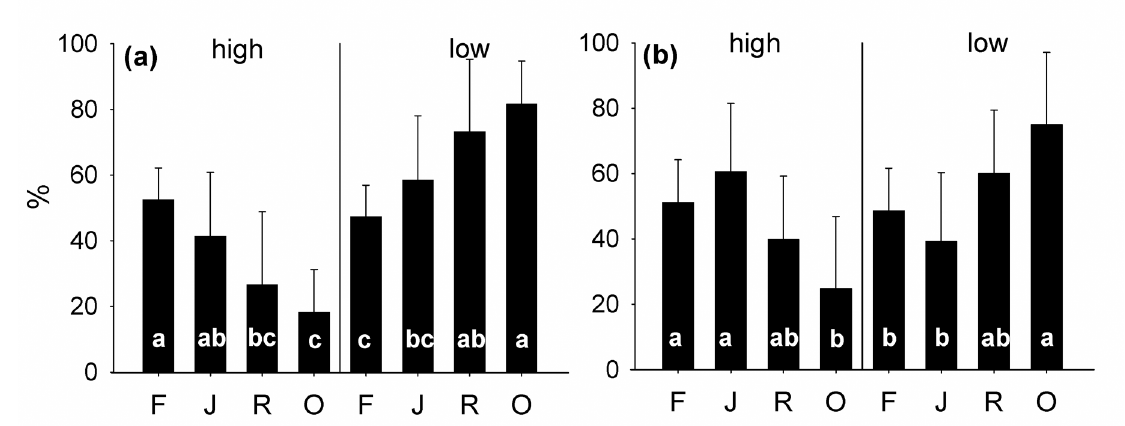
Fig 4. Relative density (percentages of total) of testate amoebae species of high and low trophic level in litter (a) and soil (b) of four land-use systems: rainforest (F), jungle rubber (J), rubber (R) and oil palm (O); mean with SD (n = 8). Bars sharing the same letter do not differ significantly (Tukey ’ s HSD test, p <